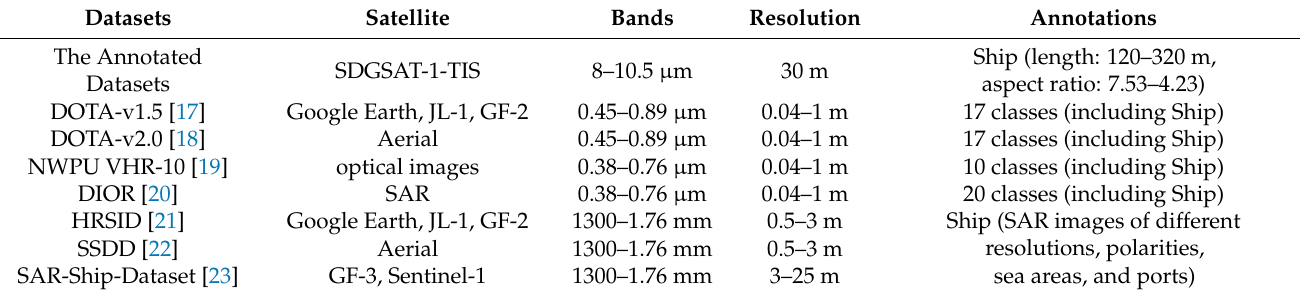
Table 2. The summary of ship